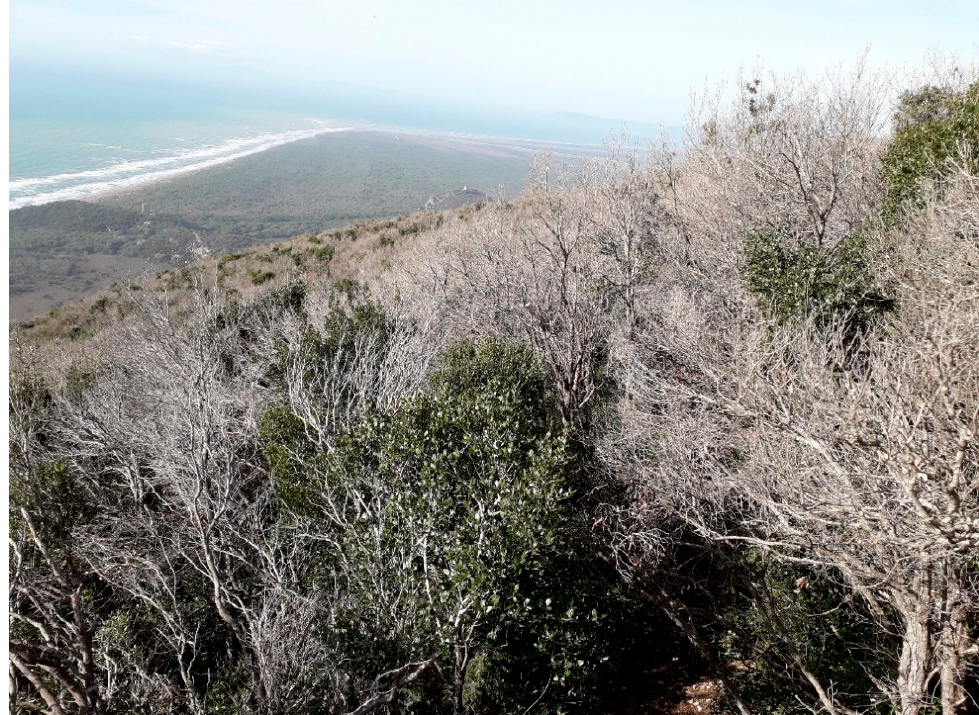
Figure 1. Quercus ilex L. (holm oak) forest stands in the Regional Park of Maremma (Tuscany, Central Italy). Trees of holm oak are completed defoliated, while Phillyrea latifolia L. trees show green canopy (photo by M. Pollastrini, 20 January 2020).